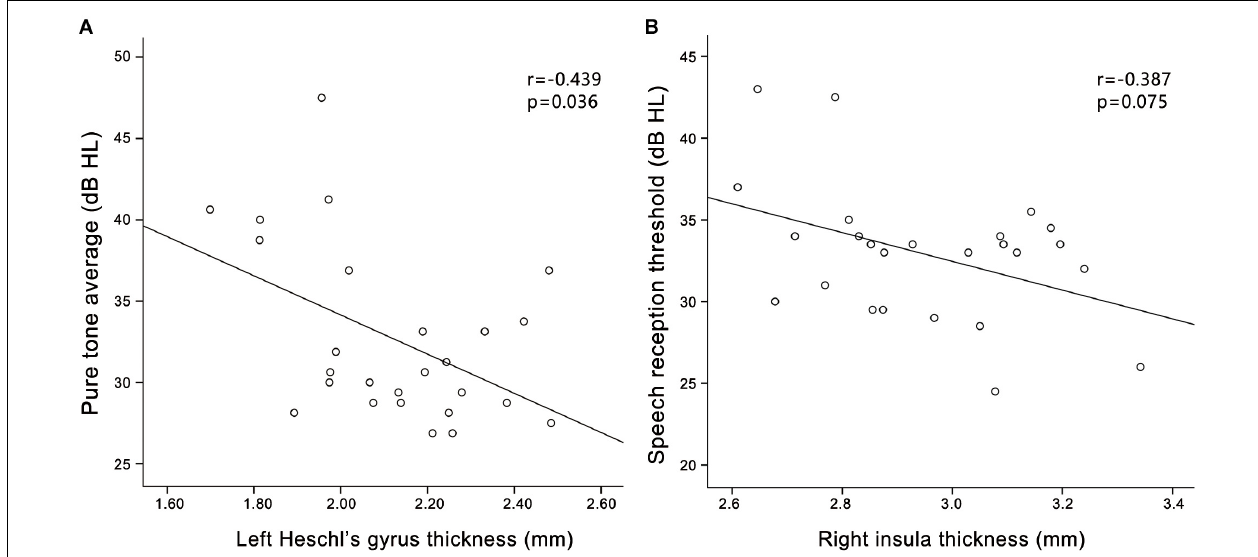
FIGURE 5 | Correlations between structural changes and audiological outcomes in the presbycusis group. (A) PTA was negatively correlated with the cortical thickness of the left HG ( r = –0.439, p = 0.036); (B) A trend toward correlation was seen between SRT and the cortical thickness of the right insula ( r = –0.387, p =